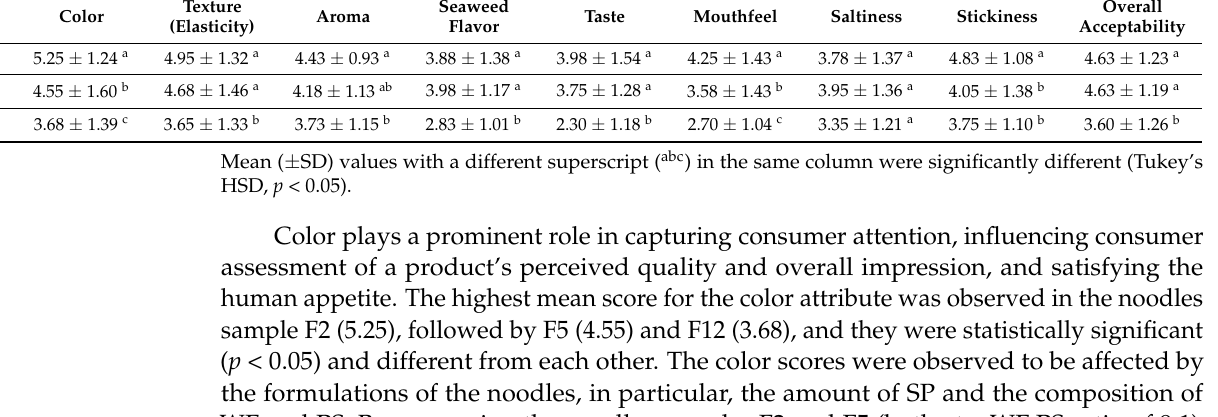
(Tukey’s HSD, p < 0.05).